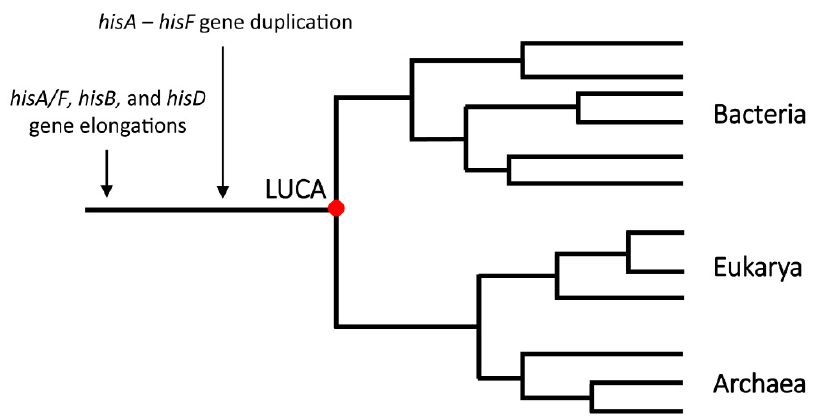
Figure 11. Schematic representation of the occurrence of the gene elongation events in the evolution of his genes throughout phylogeny.